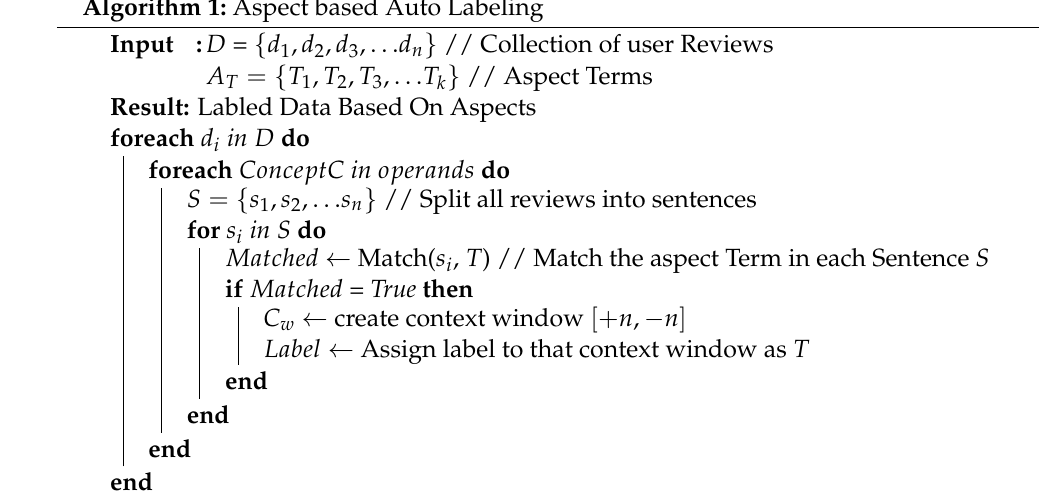
Algorithm 1: Aspect based Auto Labeling